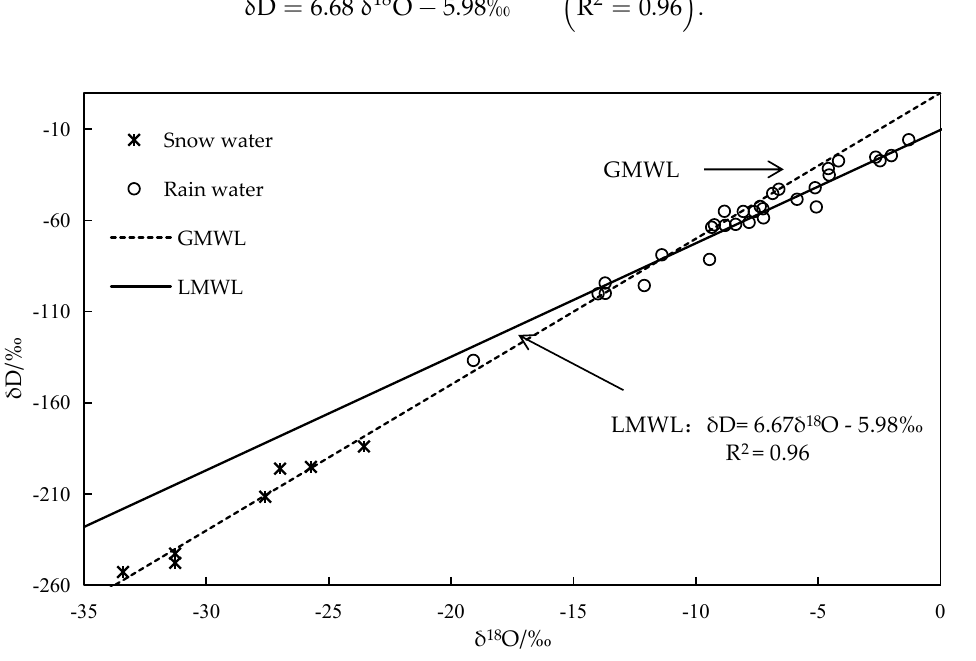
Figure 2. Meteoric lines in the Lake Hulun area.